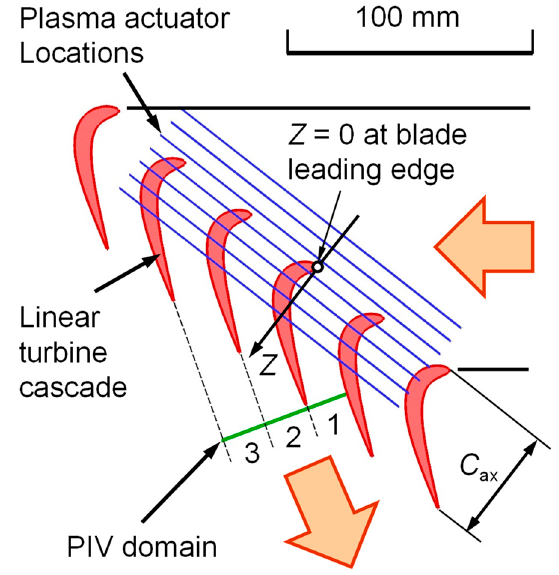
Figure 4. Installation locations of the plasma actuator. Table 3. Inlet and outlet freestream velocities and Reynolds numbers of the linear turbine Table 2. Plasma actuator locations.